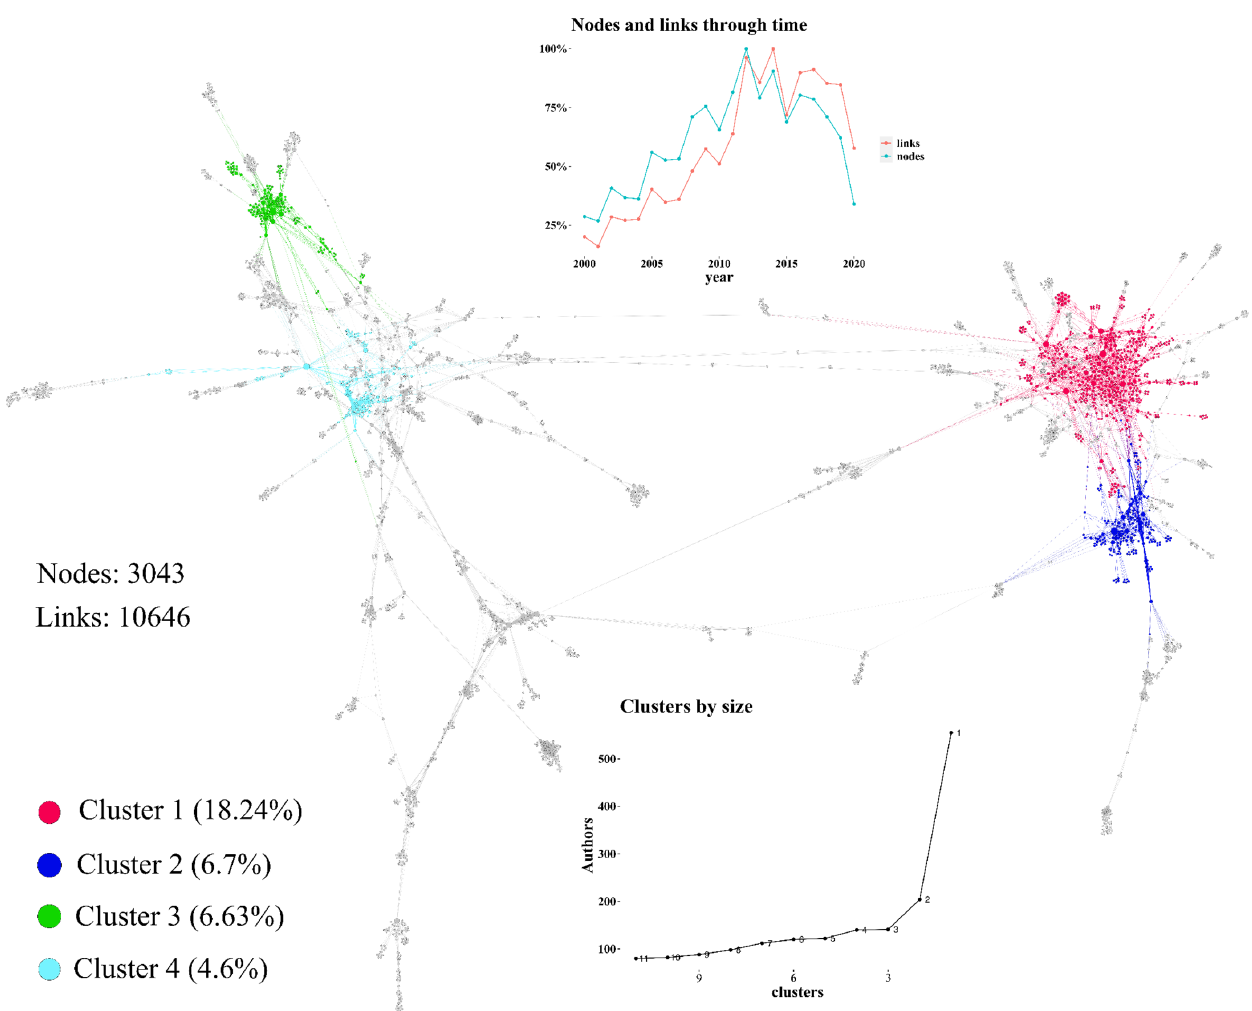
Figure 4. Academic social network of coffee by-product